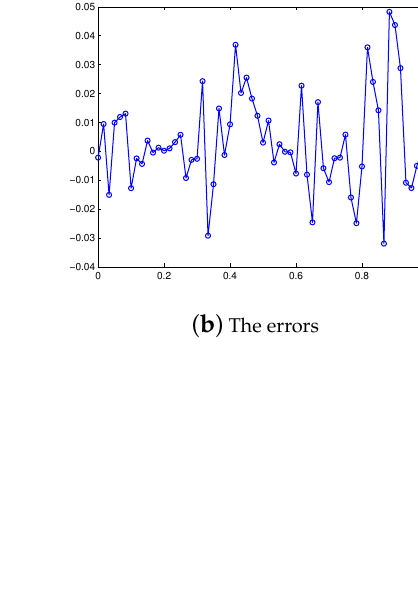
Figure 6. Apple-shaped domain; the numerical solutions and the relative errors of u in each knot with the the percentages of noise increasing from 1% to 5% on Γ for Example 5.